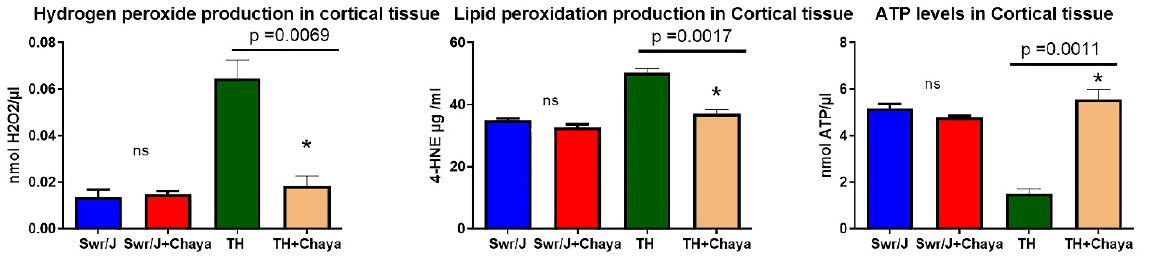
Figure 11. Mitochondrial functional parameters, including hydrogen peroxide, mitochondrial ATP, and lipid peroxidation (4-hydroxy-nonenol) were measured in the cortex of SWR/J control mice fed with regular chow and chaya chow, and TH mice fed with regular chow and chaya chow. The data are mean ± SD ( n = 5 for each group). The TH + chaya mice showed significantly decreased levels of hydrogen peroxide ( p = 0.0069) and lipid peroxidation ( p = 0.0017), with significantly increased levels of ATP ( p = 0.0011). * p = 0.01.